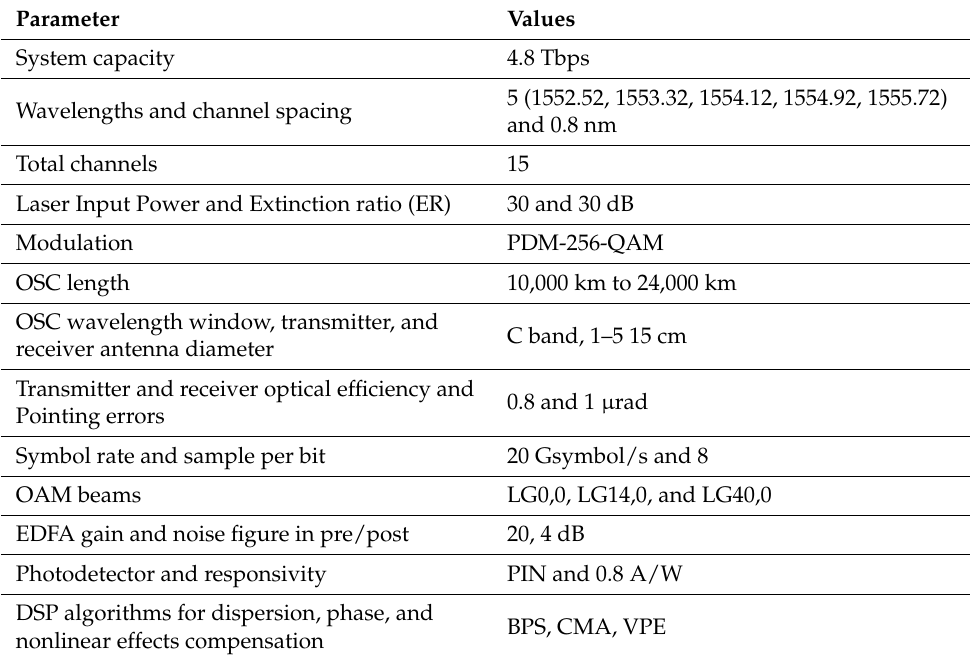
Table 1. Simulation parameters of proposed OAM-OSC